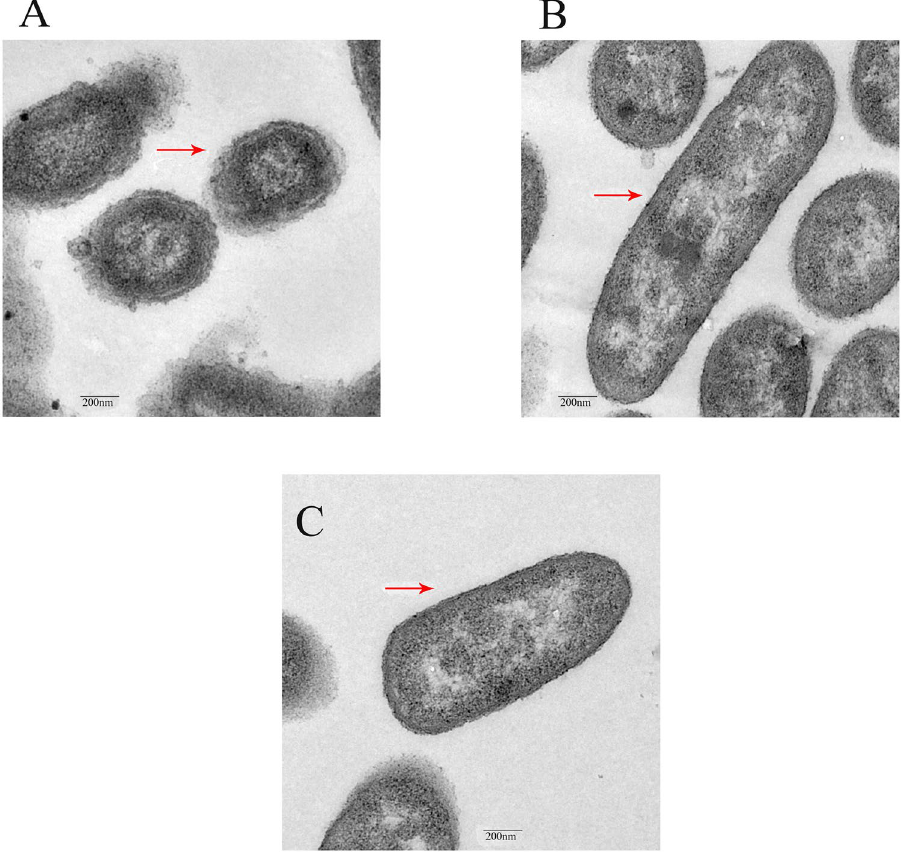
Figure 2. Comparison of transmission electron microscope: ( A ) presents JS0135 , ( B ) presents JS32 , ( C ) presents HB32 . Red arrow pointed to the membrane of